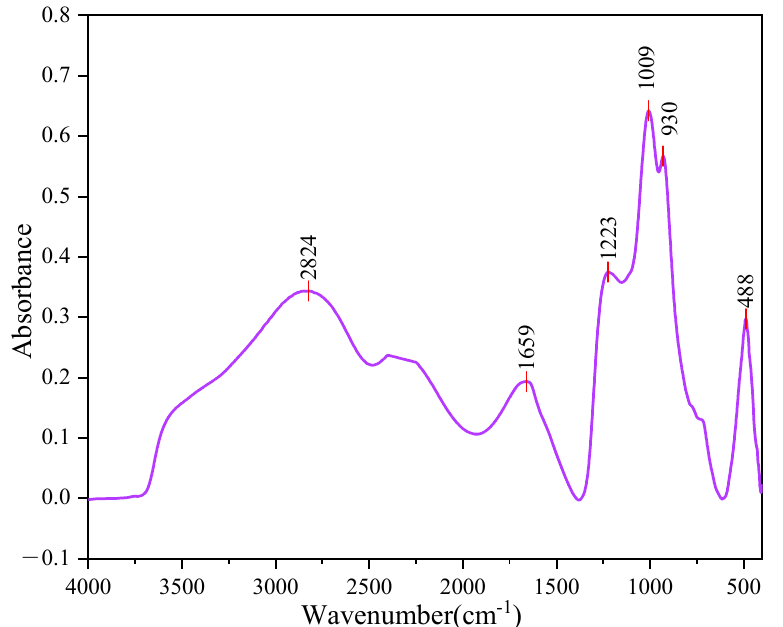
Figure 8. FTIR spectrum of. polyphosphoric acid (PPA).